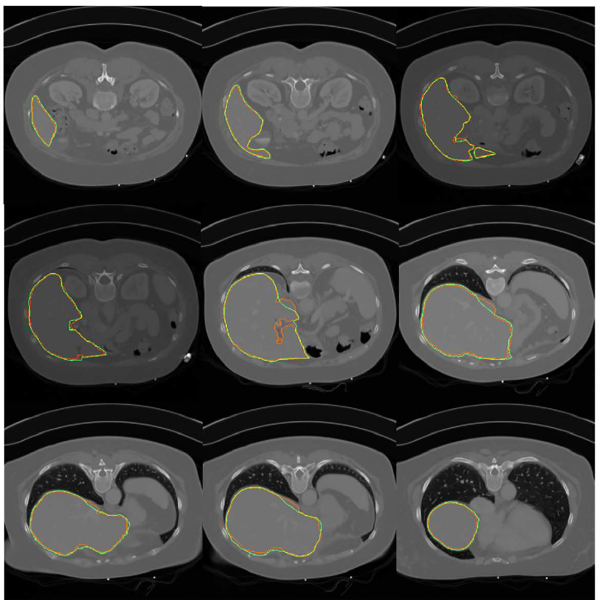
Fig 8. Segmentation results on each